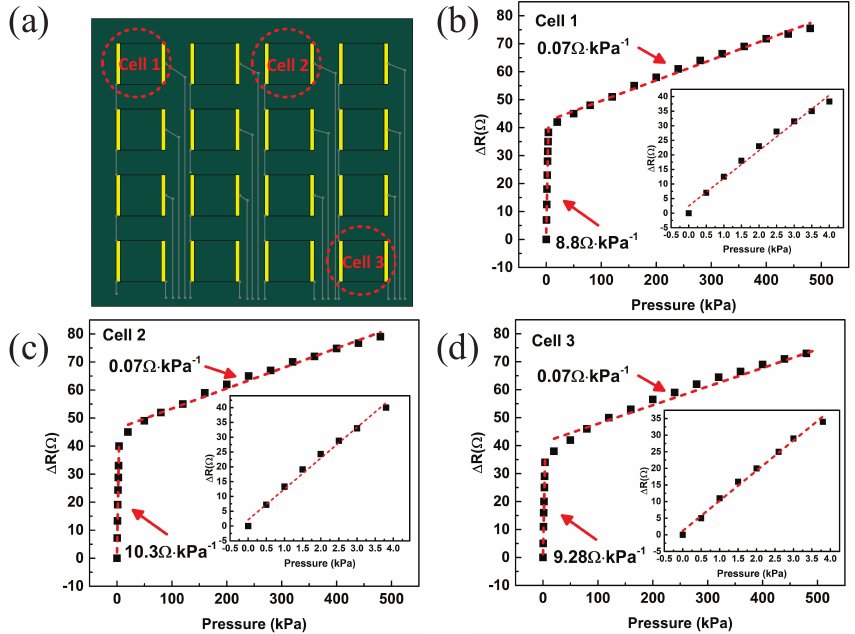
Figure 8. ( a ) Schematic diagram of the location of the sensing unit; ( b – d ) Pressure resistance characteristic curves of the sensing